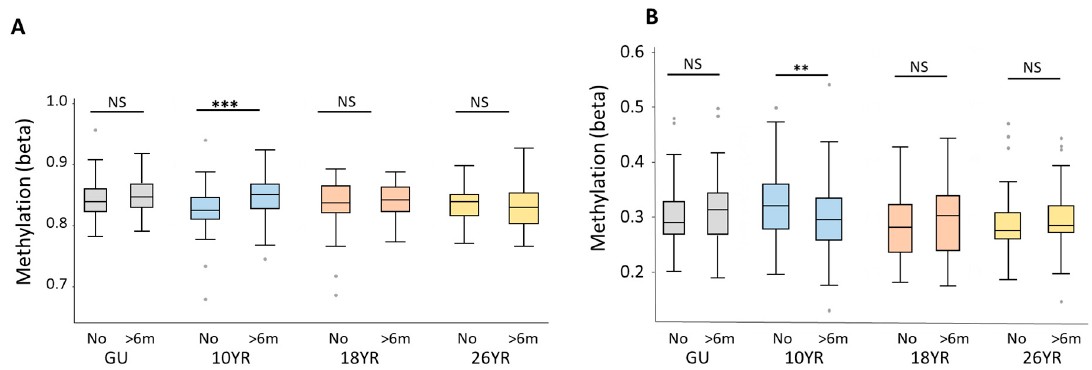
Figure 3. Influence of breastfeeding on the distribution of the beta values (methylation levels)